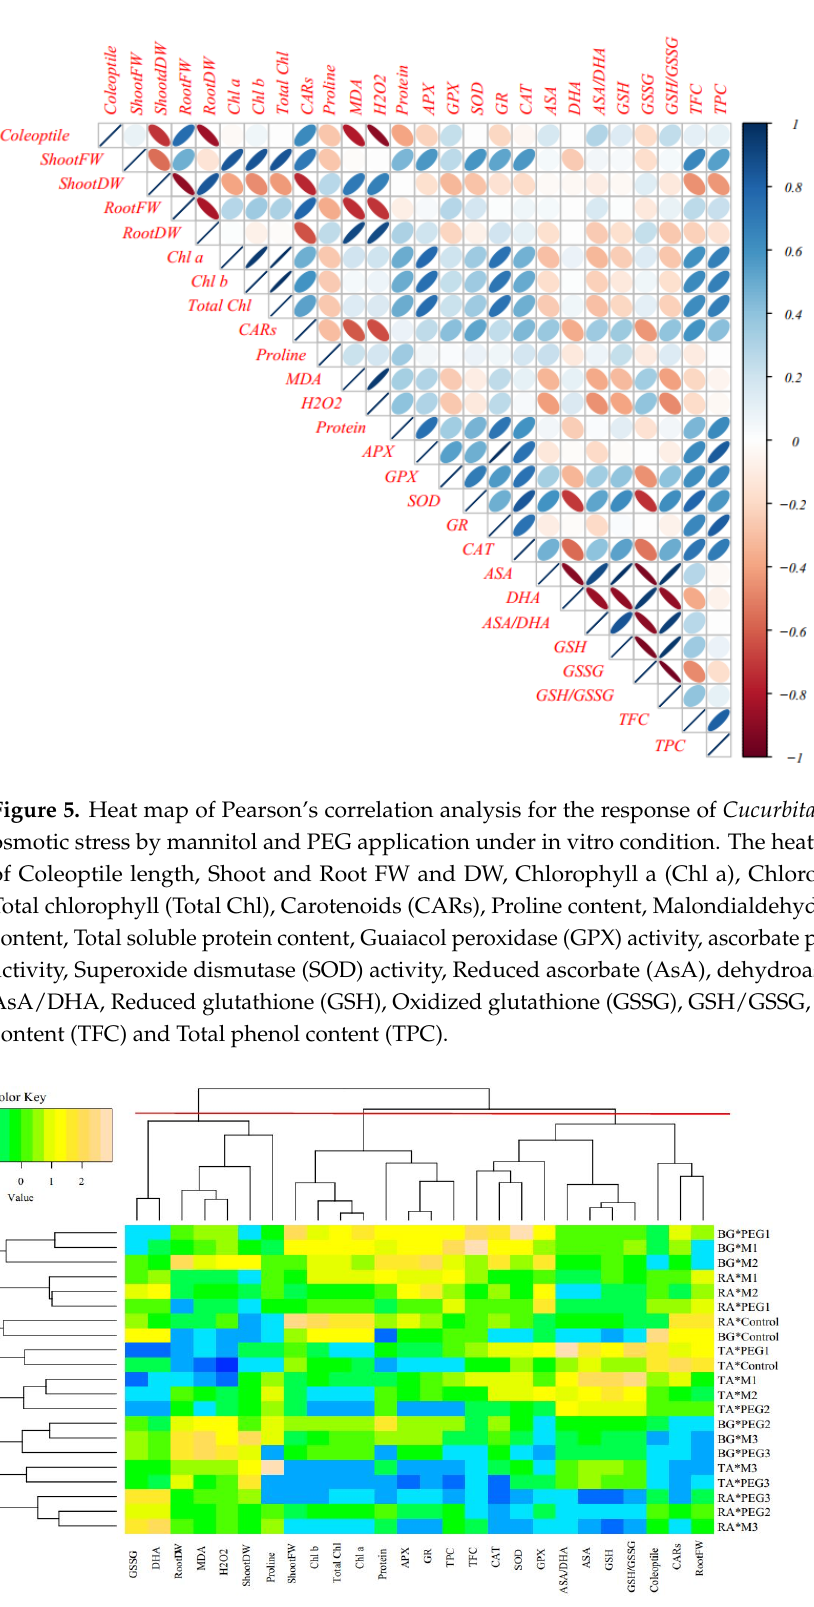
14 of 21 Figure 4. Effects of PEG and mannitol on (AsA) (nM g − 1 FW) ( A ), reduced glutathione (GSH) (nM g − 1 FW) ( B ), dehydroascorbate (DHA) (nM g − 1 FW) ( C ), oxidized glutathione (GSSG) (nM g − 1 FW) ( D ), ASA/DHA) ( E ), and GSH/GSSG ( F ) in Cucurbita sp. genotypes under in vitro conditions. Dif ‐ ferent letters are significantly different based on Duncan’s multiple range test ( p ≤ 0.05). 3.11. Multivariate Analysis of Cucurbits Landraces under Normal and Mannitol and PEG Treatments The Pearson’s correlations of morphological, biochemical and antioxidant traits is ex ‐ hibited in Figure 5 The findings showed that coleoptile length positively correlated with